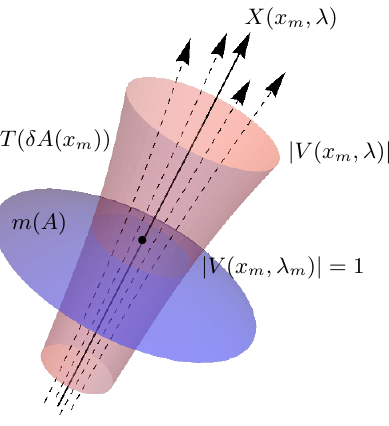
Figure 1 . Schematic representation of the conservation of (cid:13)ux, for an in(cid:12)nitesimal tube made of integral curves around a point x m . The construction is local, so the j V j obtained with this method is valid for all points away from the minimal surface. The (cid:12)nal non-trivial check is to verify that the bound j V j (cid:20) 1 is respected